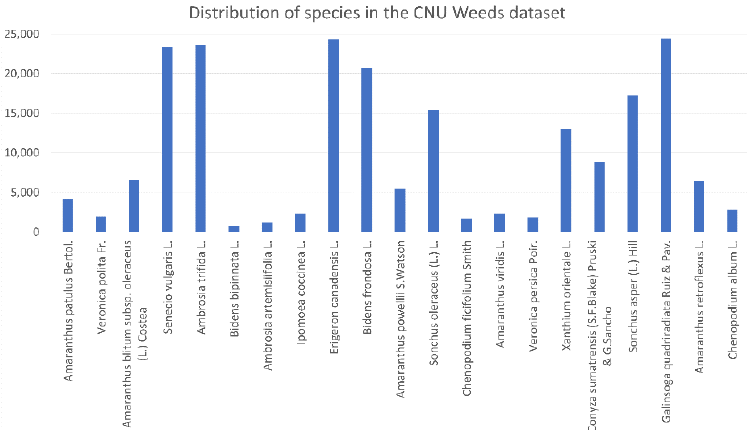
Figure 5. Distribution of species in the CNU weeds dataset.